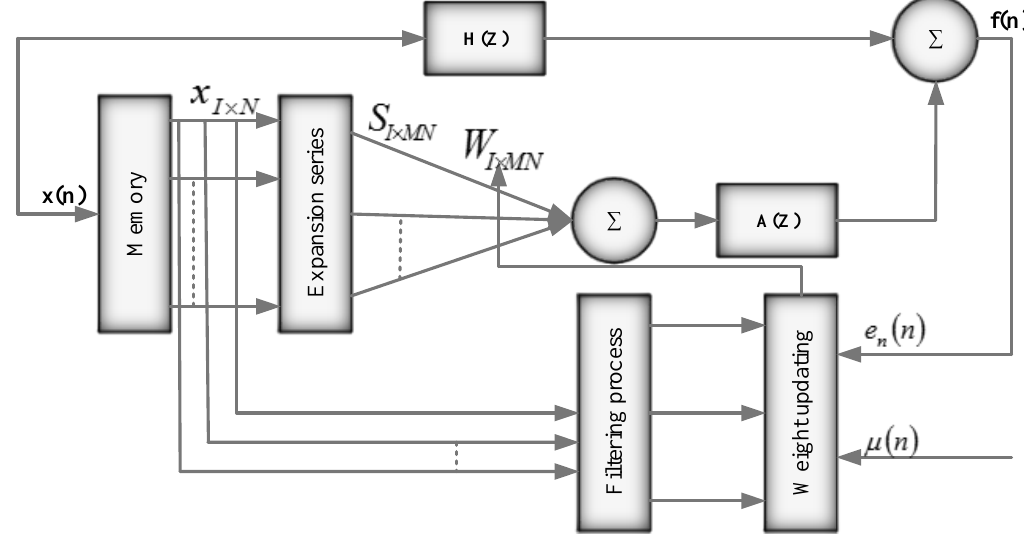
Figure 2. Active noise control with modified FsLMS.